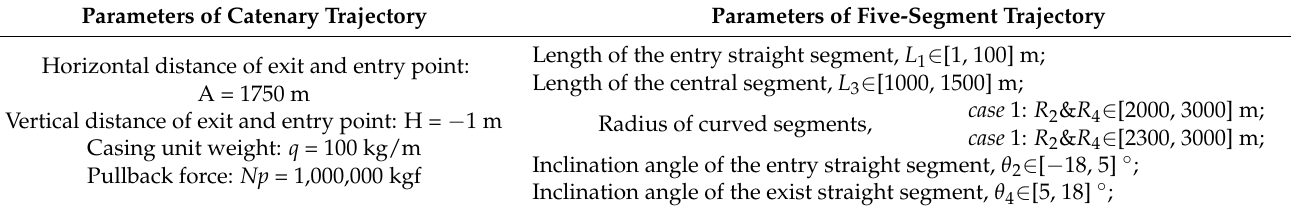
Table 7. Parameters and range setting.